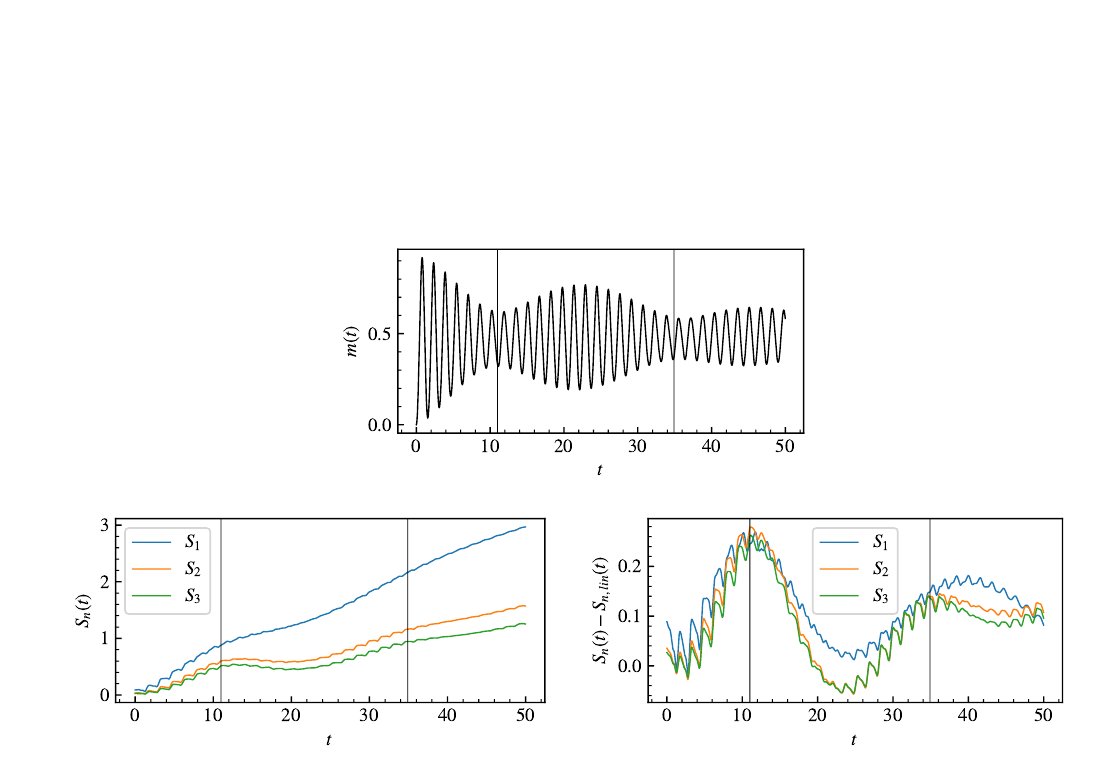
Figure B.7: Time evolution of various quantities after a large quench ( g ) = ( 2.0,0.0 ) → ( g , h ) = ( 2.0,0.8 ) in the quantum Ising spin chain. The , h 0 0 top left diagram shows the evolution of magnetisation, the top right one the von Neumann entropy ( S ) and two of the Rényi entropies ( S 1 one shows the entropy evolution with the linear trend subtracted. The vertical lines correspond to a single period of the slow oscillation corresponding to the frequency − m 2 m . The first line is drawn at the first minimum of the envelope of the magneti- 1 2 sation oscillations while second is drawn at a distance given by the period T ≈ 23.9. Note that their position also matches the behaviour of the entropy curves quite well. Time is measured in units of 1 / J , and the initial entropy was